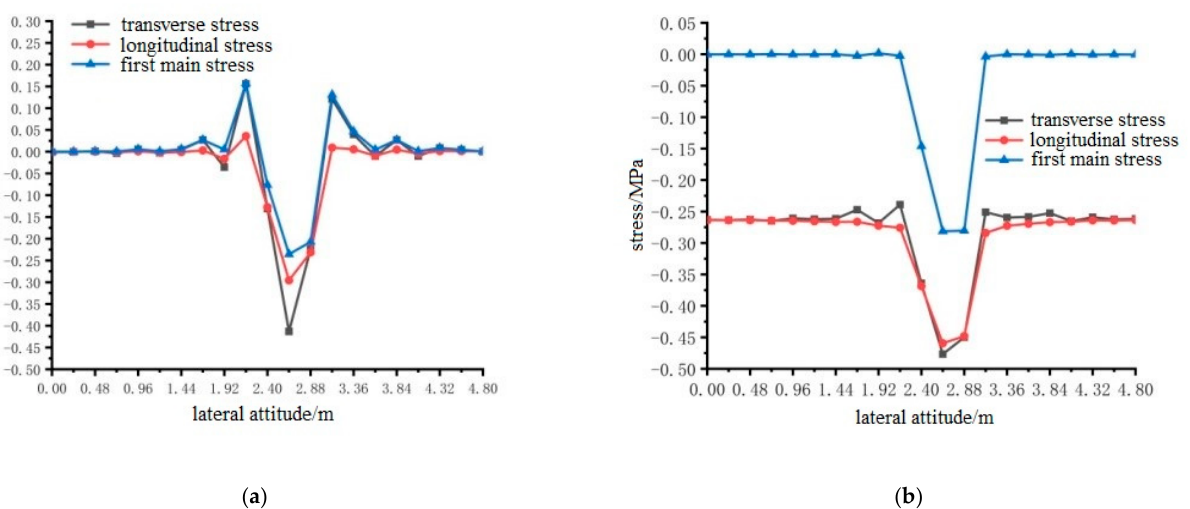
Figure 26. The transverse distribution of longitudinal and transverse stress on the surface of the pavement layer with and without temperature field under the action of load level 3. ( a ) Longitudinal and transverse stress diagrams without temperature field. ( b ) Longitudinal and transverse stress diagrams with temperature field effect